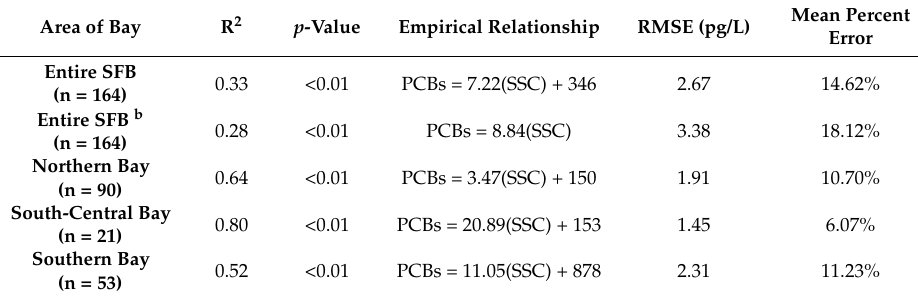
Table 1. Statistical relationships between SFEI-sampled PCBs and SSC.